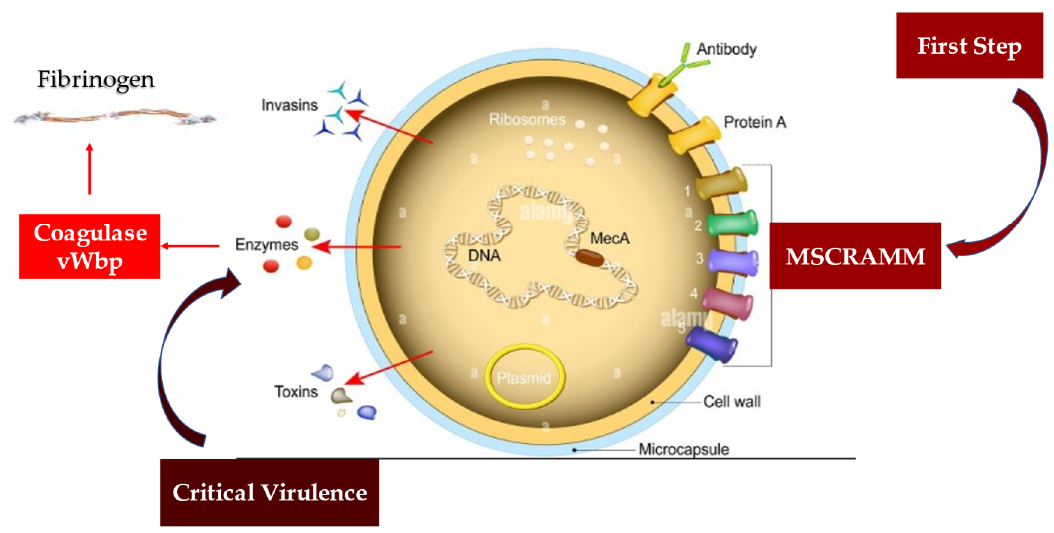
Figure 6. Depiction of virulent factors of S. aureus. MSCRAMMs have a substantial key role in driving the initiation of endovascular, bone and joint, and prosthetic device infections. These structures can bind to molecules such as collagen (mostly via Cna), fibronectin (via FnbAB), and fibrinogen (with ClfAB and Fib), and thus evade the immune system. The development of infection is induced by Coa and von Willebrand factor-binding protein that led to critical virulence. Coa binds preferentially to soluble fibrinogen, while vWbp does not disclose any preference between the two forms of fibrinogen. Abbreviations: Clf, cell-bound clumping factor; Coa, coagulase; Fnb, fibronectin binding protein; MSCRAMM, microbial surface components recognizing adhesive matrix molecules; vWbp, von Willebrand factor-binding protein.